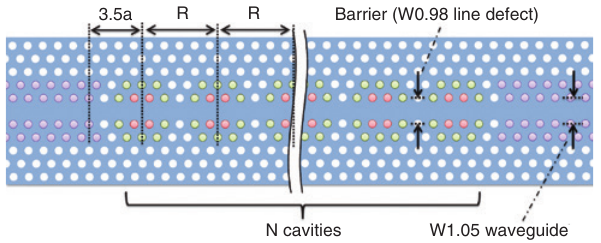
Figure 5: A CROW consisting of photonic-crystal mode gap nanocavities. The positions of the red and green holes are shifted by 8 and 4 nm toward the outside, respectively